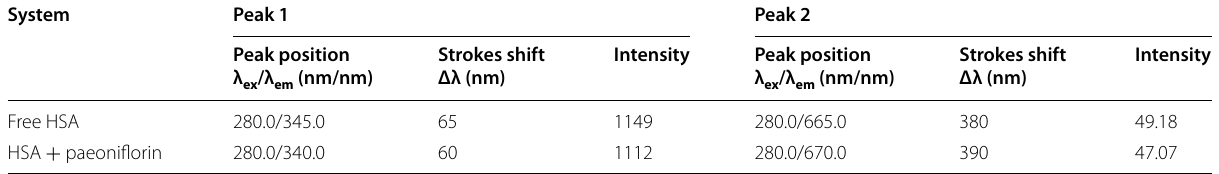
paeoniflorin sys- +